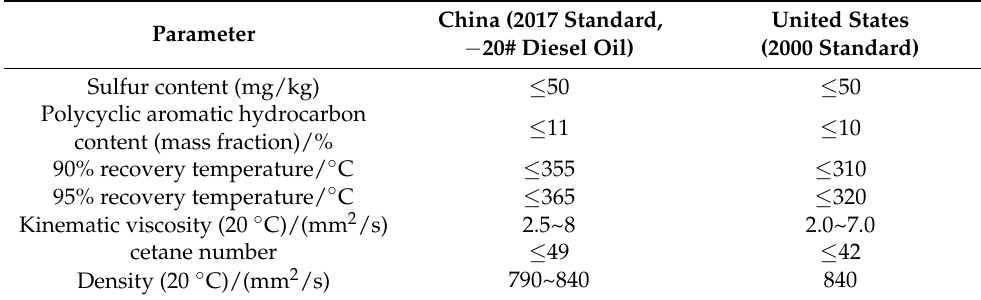
Table 2. Comparison of diesel oil quality between China and